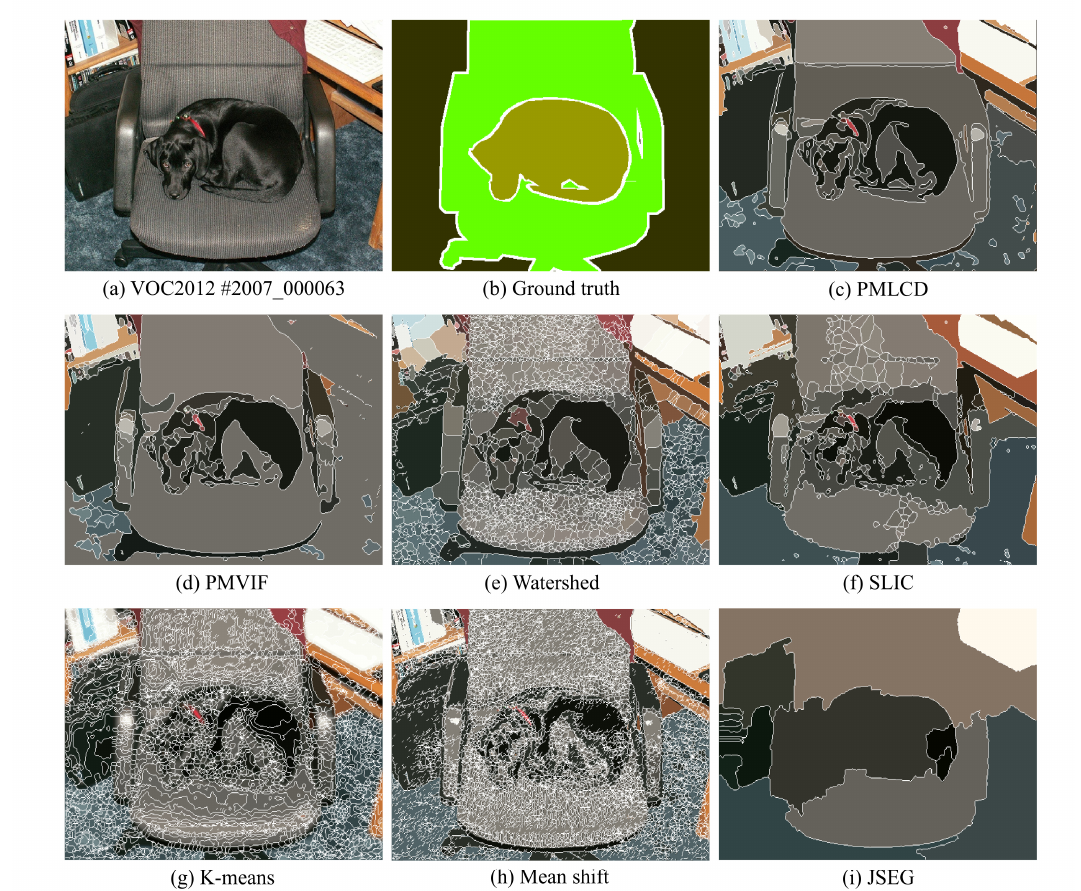
Figure 9. Color image segmentation results of the image #2007_000063 from VOC2012.